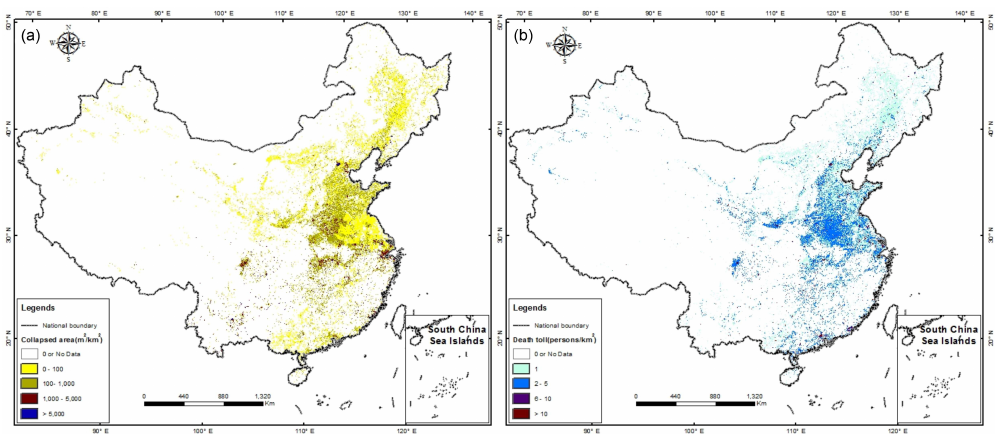
Figure 5. Example of the pre-calculated earthquake loss estimation data set: (a) “collapse” under intensity X of B1 type building; (b) human losses due to intensity X in